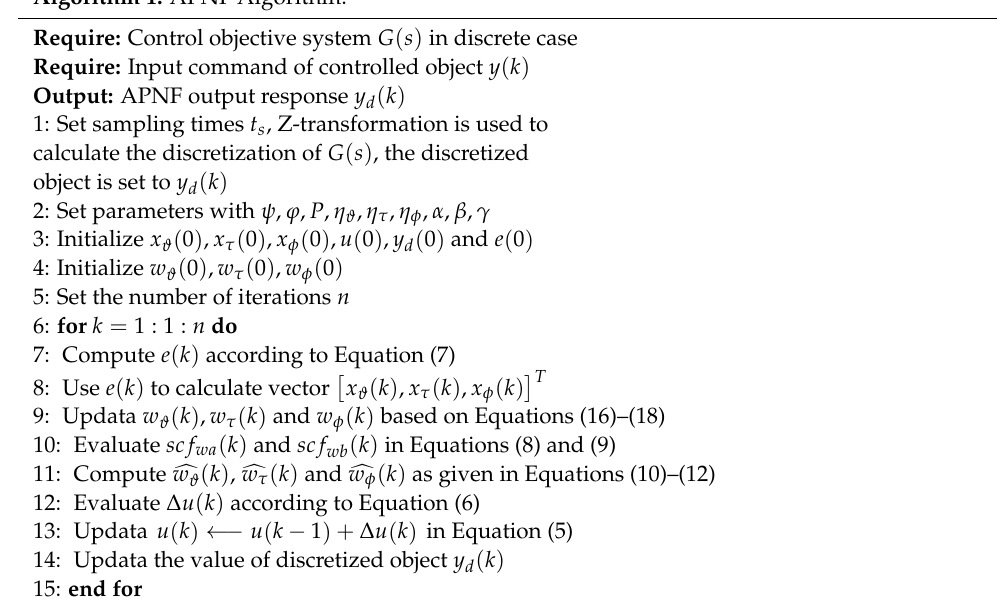
Algorithm 1. APNF